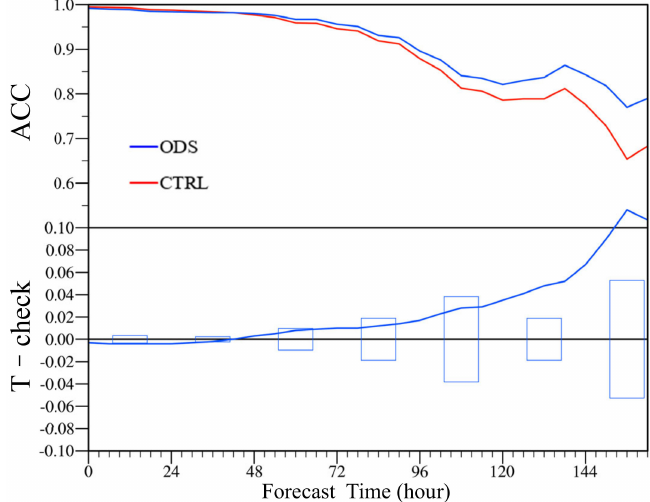
Figure 10. The ACC of the geopotential height at 500 hPa in the northern hemisphere between the FNL data and the forecasts of the two experiments (blue curve is for ODS experiment, red curve is for the CTRL) from 0900 UTC 8 August to 0900 UTC 9 August 2019. The blue curve is the ACC di ff erence